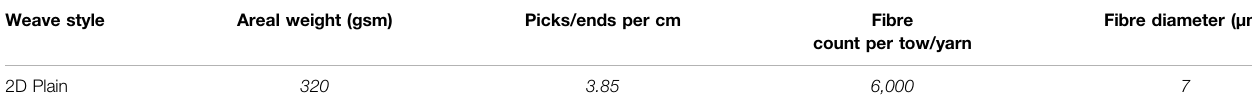
TABLE 4 | Measured test case material information.